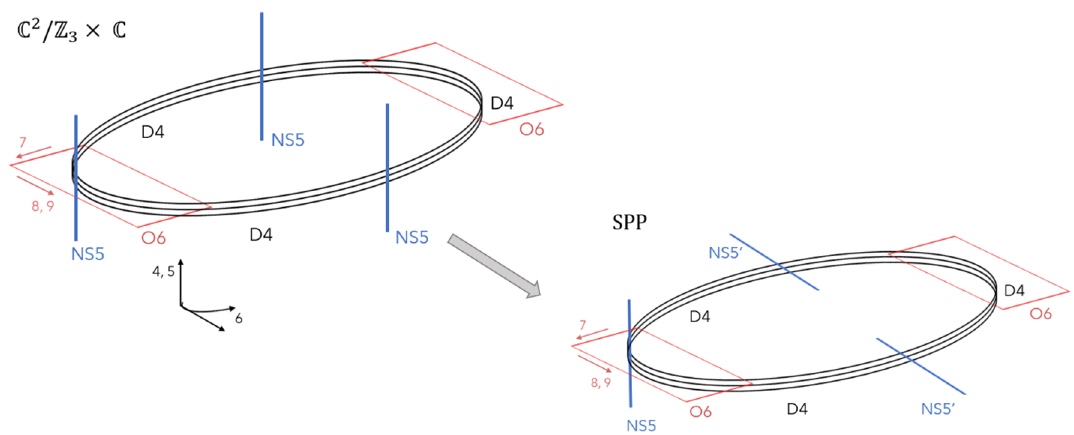
Figure 9. The theories C 2 / Z 3 × C and suspended pinch point (SPP) represented via IIA elliptic models. Rotating NS5 branes results in mass deforming the